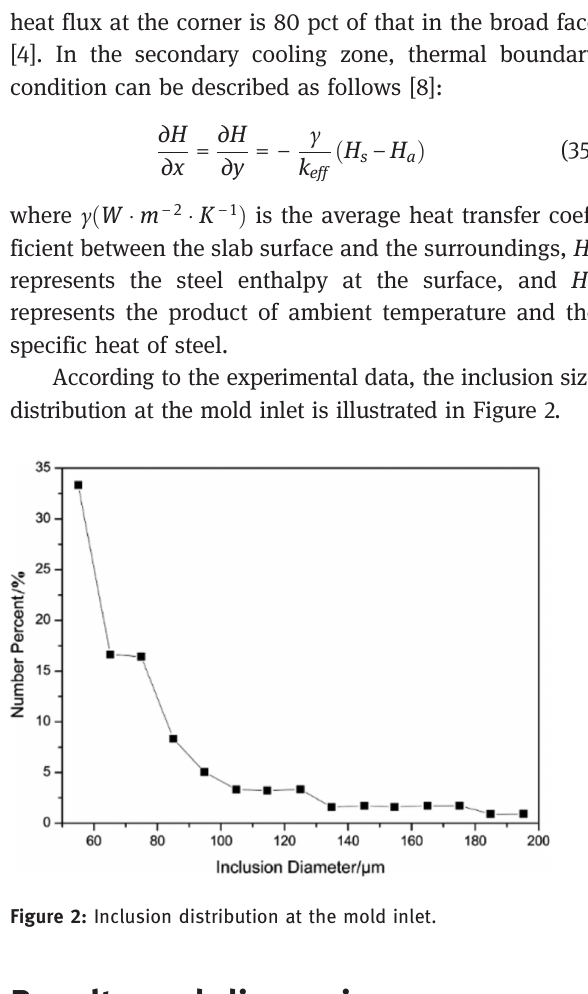
Table 1: Properties of steel and boundary condition. Parameters Values Dimensions